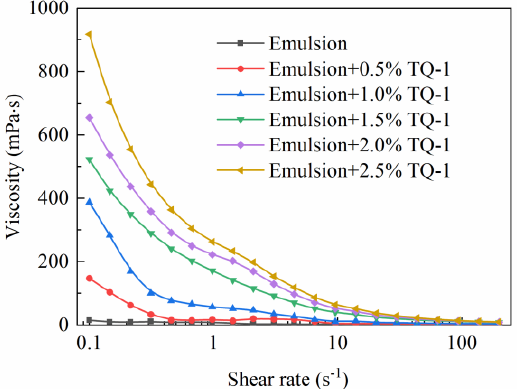
Figure 7. Effect of TQ-1 on the rheological curve of the invert emulsion.